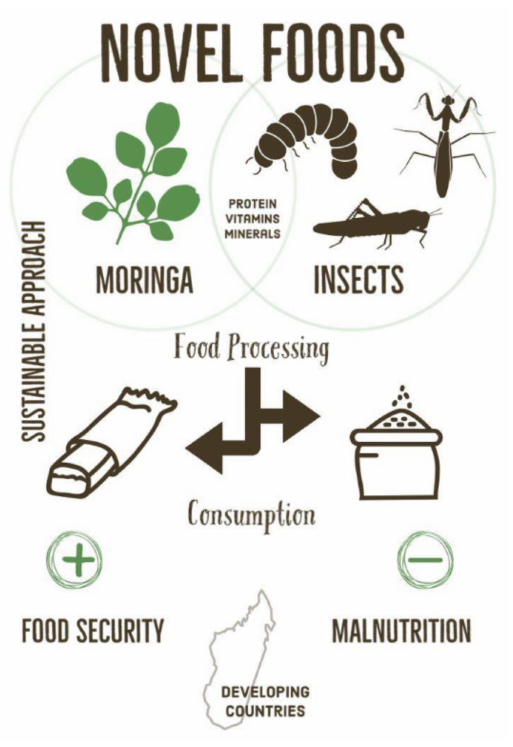
Figure 1. The figure summarizes what the manuscript wants to communicate: how novel foods— specifically Moringa and insects in this case—could represent a sustainable approach to counteract malnutrition in developing